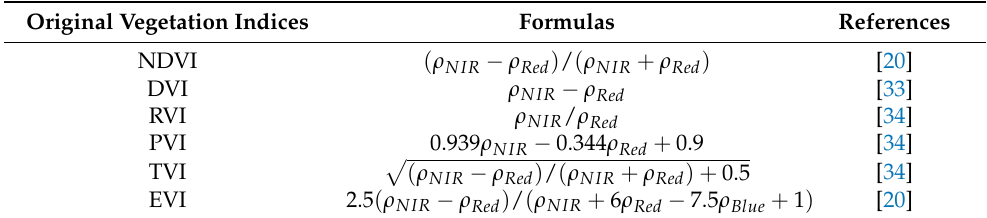
Table 3. Several traditional vegetation indices calculated based on Sentinel-2 data. Original Vegetation Indices